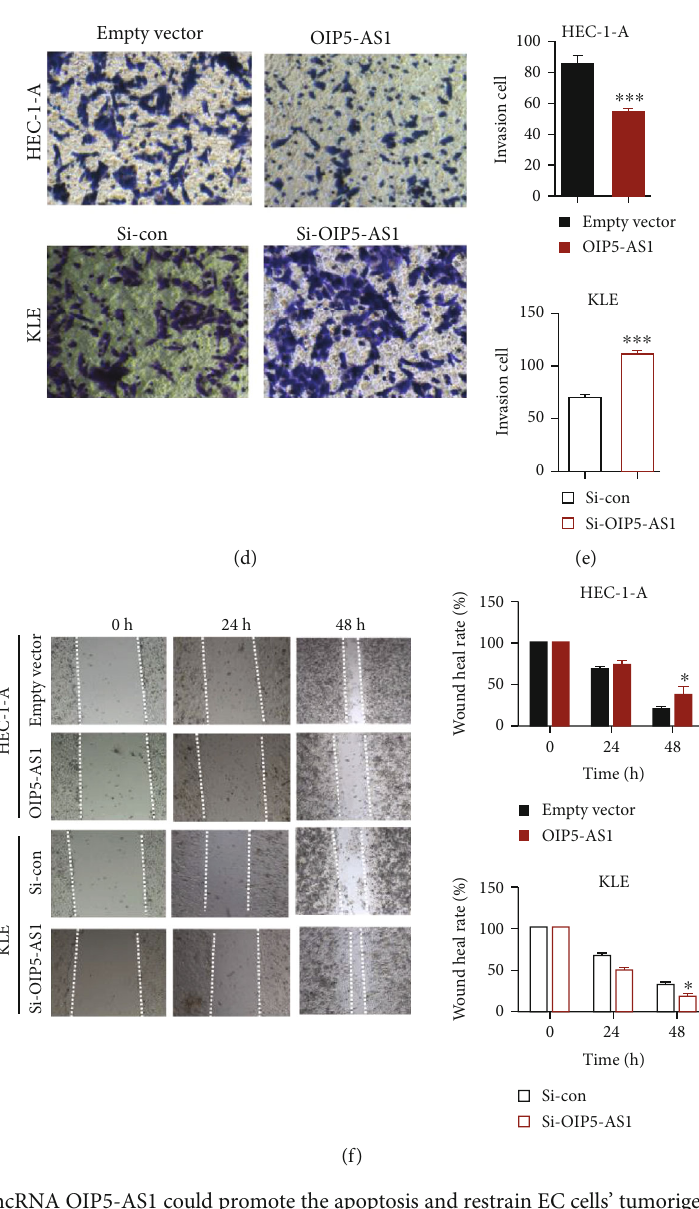
Figure 3: Overexpression of lncRNA OIP5-AS1 could promote the apoptosis and restrain EC cells ’ tumorigenic potential. (a) Measurement of apoptotic cells with OIP5-AS1 overexpression by FACS assay and calculated percentage of apoptotic cells. ∗∗∗ P < 0 : 001 and ∗ P < 0 : 05 . (b) Western blot analysis of cell death-related protein Bcl-2 and cleaved-caspase3, and the internal control is GAPDH. (c) Colony formation assay detected cell proliferation in OIP5-AS1-upregulated HEC-1-A cells and OIP5-AS1-downregulated KLE cells. (d, e) Transwell assay to test the invasion ability of HEC-1-A and KLE by altering the level of OIP5-AS1. ∗∗∗ P < 0 : 001 . (f) Wound healing assay to identify the migration capacity of two EC cells after transfecting the OIP5-AS1 vector and Si-OIP5-AS1 for 48 hours. ∗ P < 0 : 05